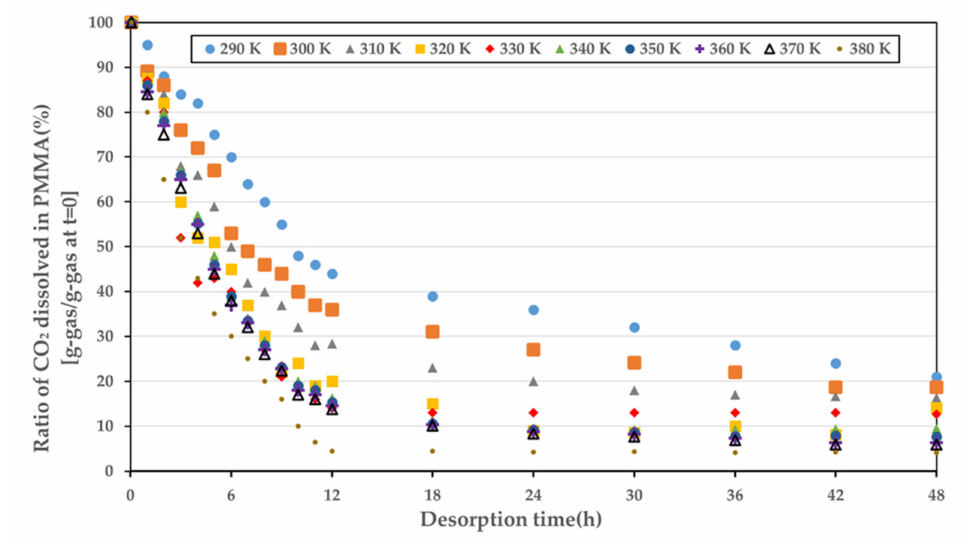
Figure 6. Desorption curves for various temperatures at atmospheric